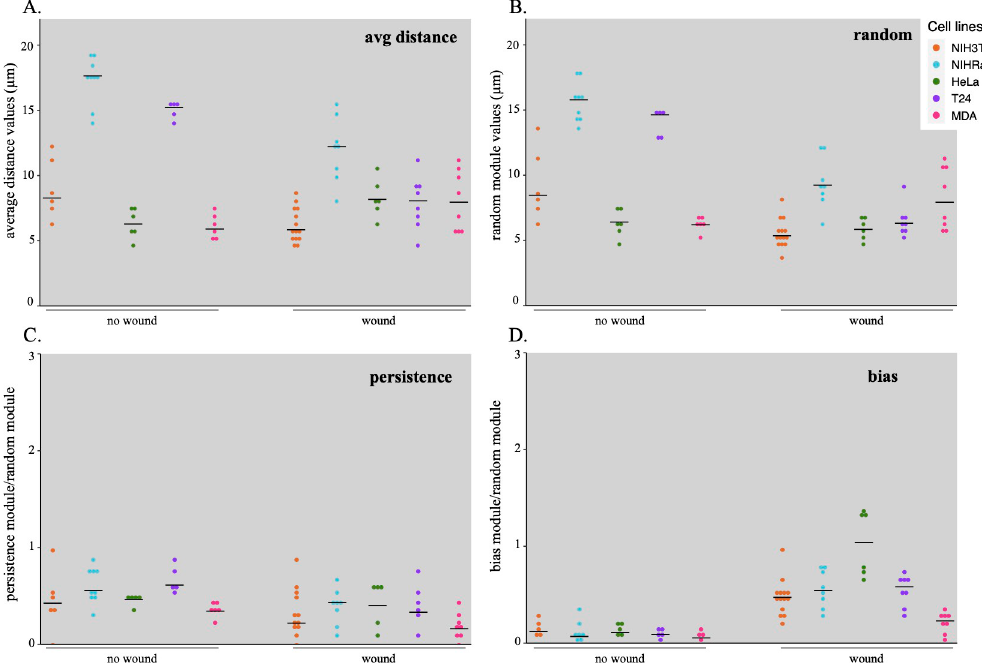
Fig 6. Movement of different cell lines in wound healing experiments. NIH-3T3 (orange), NIH-Ras (blue), HeLa (green), T24 (violet) and MDA-MB-231 (magenta) cell lines were grown on a culture plate and their movement was followed in both standard condition (no wound) and after stimulation (wound) by a wound inflicted to the cell layer. (A) Average distance and (B) random module, (C) persistence and (D) bias. Values reported in (C) and (D) have been normalized against the corresponding random modules. For each cell line, coloured points correspond to independent cultures analysed over a 4 hour time window, while their median value is reported as a small horizontal black trait.